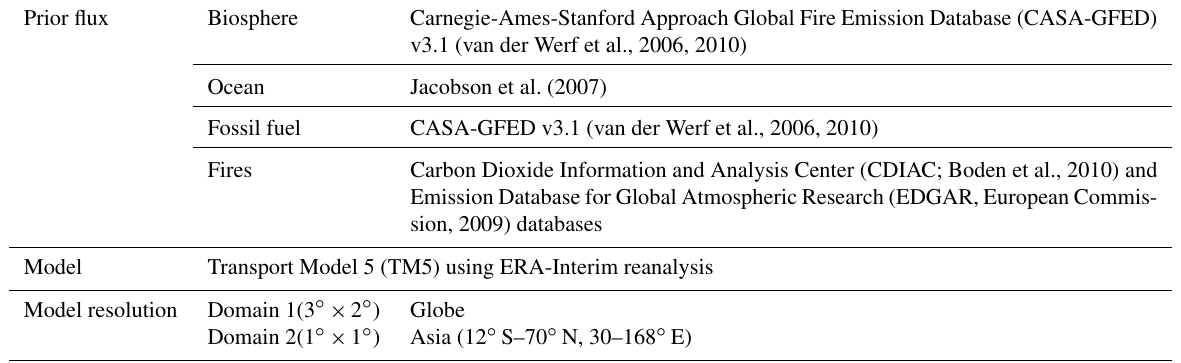
Table 1. The model configuration and a priori fluxes used in this study. Prior flux